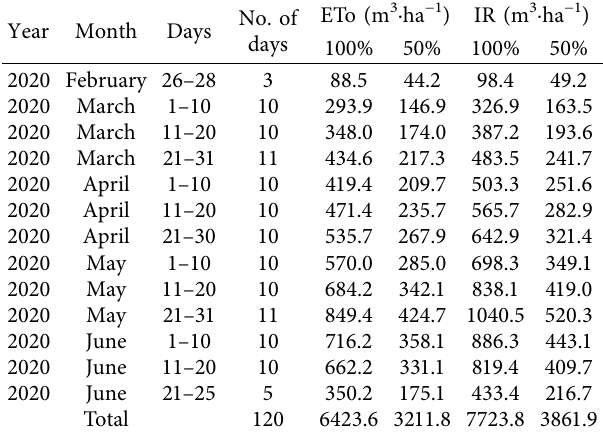
Figure 1: The data of average temperature, and relative humidity at the experimental site in 2019/20 Table 1: Values of reference crop evapotranspiration (ETo), and irrigation (IR) water amount in each water treatment throughout the experimental period of 2019/20.